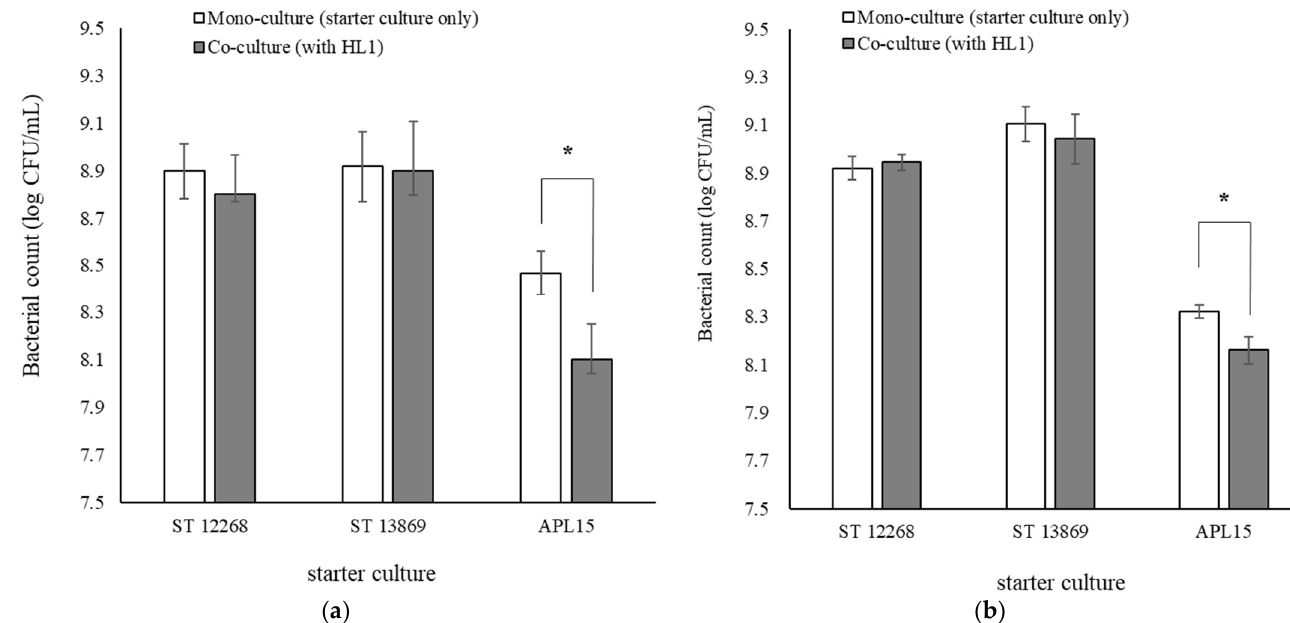
Figure 4. Effect of HL1 on bacterial counts of each selected co-culturing strain in skimmed milk at 30 °C for ( a ) 12 and ( b ) 24 h. The data are given as mean ± SD ( n = 3). *Bars with a start within the same starter culture indicate a significant difference ( p < 0.05). Abbreviations: HL1, L. kefiranofaciens HL1; ST 12268, S. thermophilus BCRC 12268; ST 13869, S. thermophilus BCRC 13869T; APL15, Lc. lactis subsp. cremoris APL15.